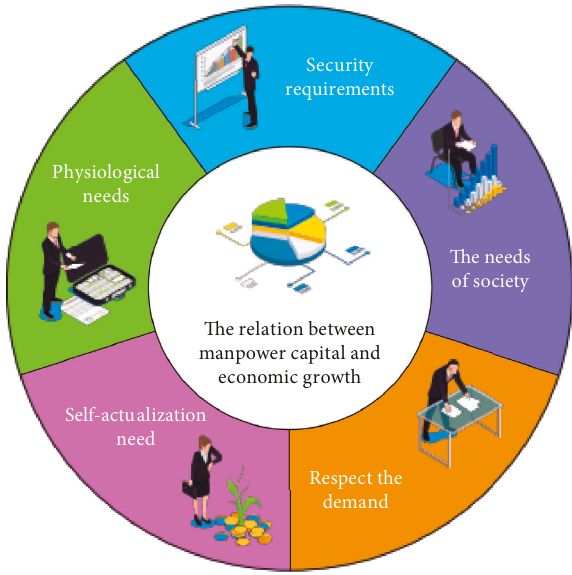
Figure 1: Required